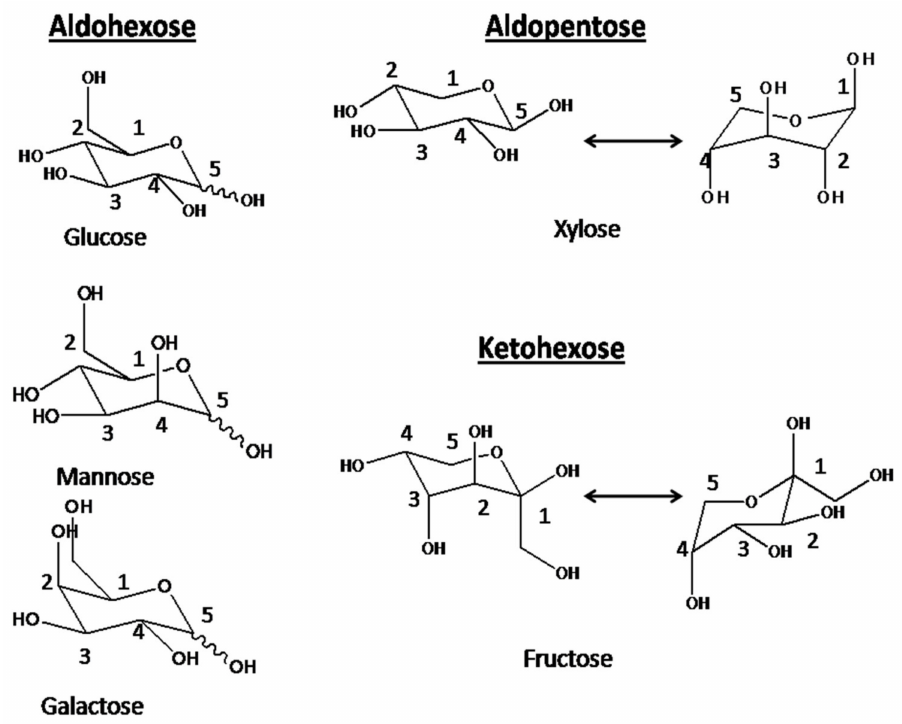
Figure 10. Cyclic chair structures for the sugar molecules: Glucose, Mannose, Galactose,